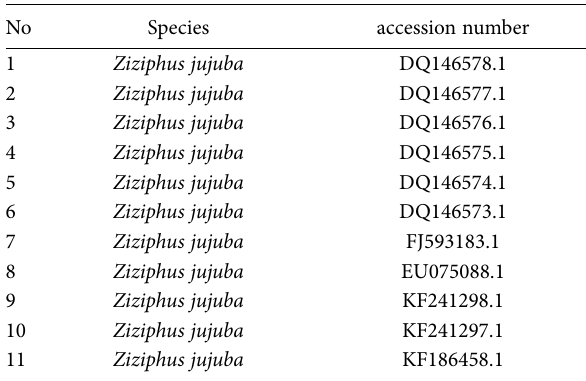
Table 3. The accession numbers of taxa in ITS studies.